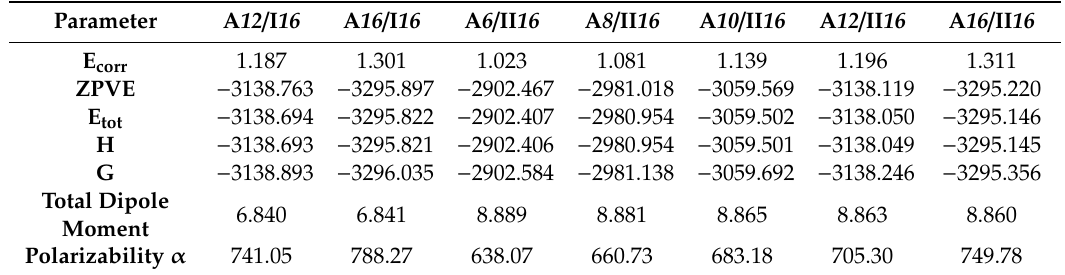
Table 3. Parameters (Hartree / particle) and dipole moment (Debye) of A 12 / I 16 , A 16 / I 16 , and A n / II m .